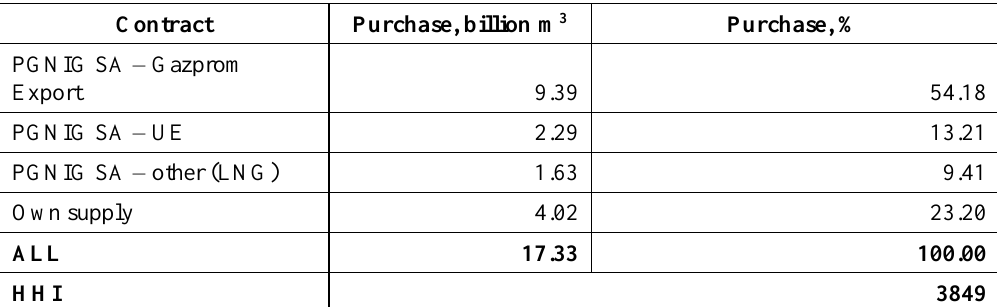
Table 3. Contracted Purchase of Natural Gas in 2017 (developed by the author, based on URE, 2018, p.